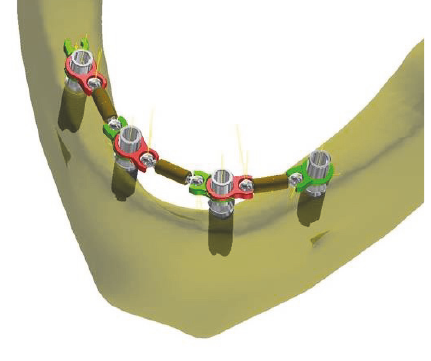
Figure1:TheBWB(BallWeldingBar)consistsofsmoothprosthetic cylinders, interconnected by means of titanium bars (grade 4) adjustable in distance with ball terminals, which are inserted in the rotating rings of the cylinders. All the components are welded and self-posing, without arcing nor tensions. This BWB has been patented by the authors (patent number AN2014A000111 and